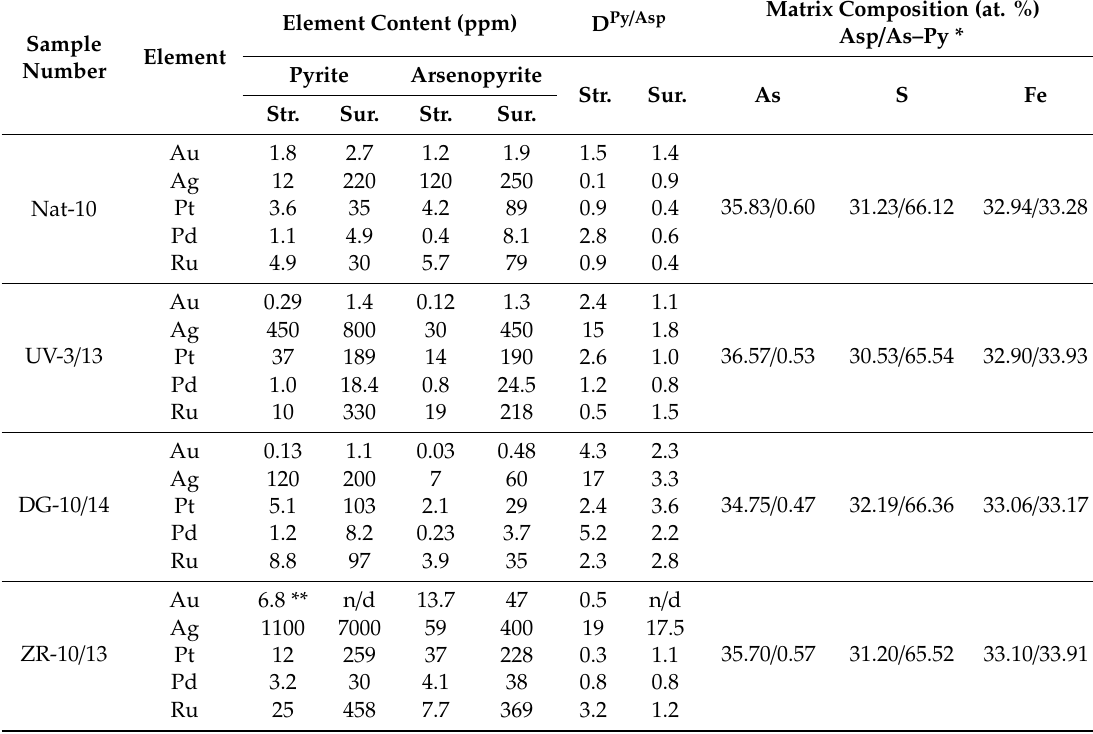
Table4. Noble metalscontents as structurallyand surficially boundmodes, their distributioncoe ffi cients between pyrite and arsenopyrite, and average matrix composition of